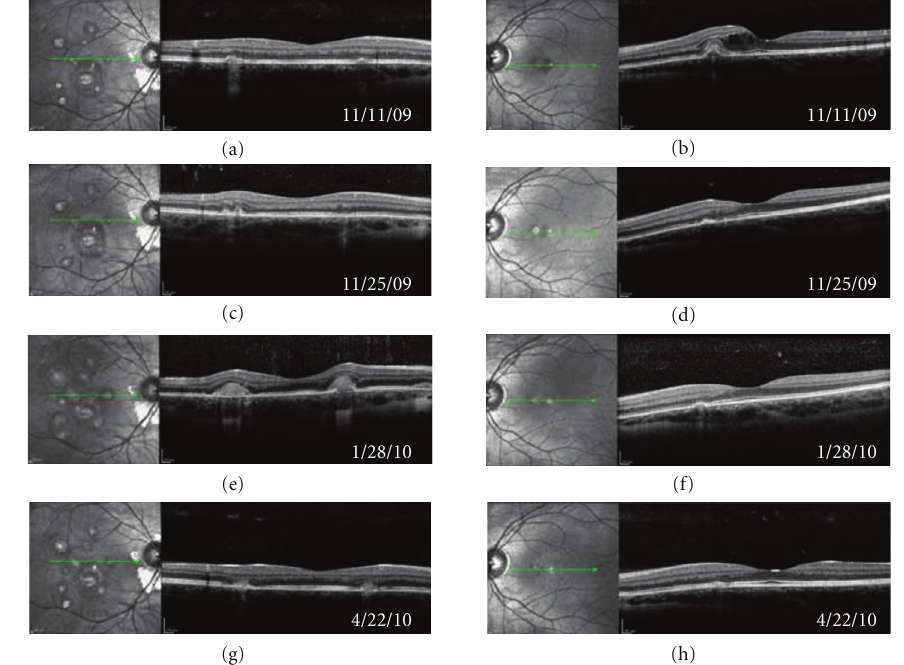
Figure 2: Spectralis spectral-domain optical coherence tomography (SD-OCT) images taken at the same location of both eyes over a 5.5- month period in a patient with recurrent punctate inner choroidopathy. (a) and (b) Initial visit. (b) Shows outer retinal irregularity and inner retinal fluid (IRF) from choroidal neovascular membrane (CNVM). (c) and (d) Followup two weeks later. After intravitreal bevacizumab treatment, left eye, shows resolution of IRF (d). (e) and (f) Two months later shortly after stopping chronic antiviral therapy. The patient experienced new photopsias, right eye, and SD-OCT revealed homogenous outer retinal thickening over chorioretinal lesions consistent with recurrent inflammatory activity (e). (g) and (h) Three months later after treatment. Symptoms subsided, and outer retinal thickening has resolved (g). Left eye shows no reoccurrence of CNVM